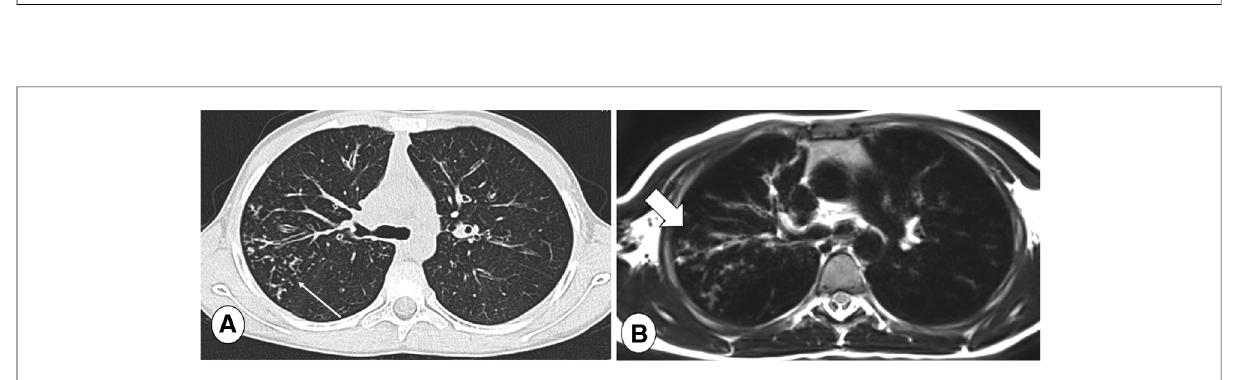
FIGURE 7 Axial CT ( A ), lung window, and axial T2-weighted MR image ( B ) in a CF patient with tree in bud in the posterior segment of the right upper lobe (thin arrow). Note loss in de fi nition of lung abnormalities in the MR image, where peripheral abnormalities may be not be visible in the MRI sequence (B, thick